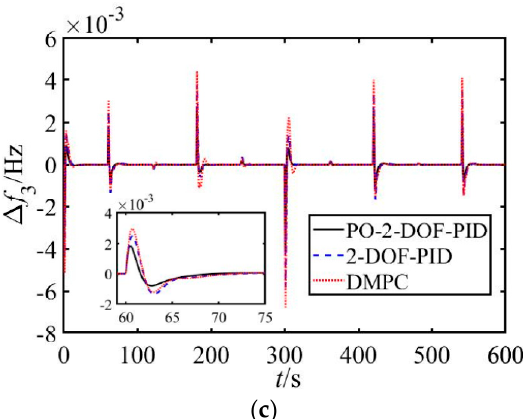
Figure 10. Frequency response under low wind speed. ( a ) Area1 ( b ) Area2. ( c ) Area3.